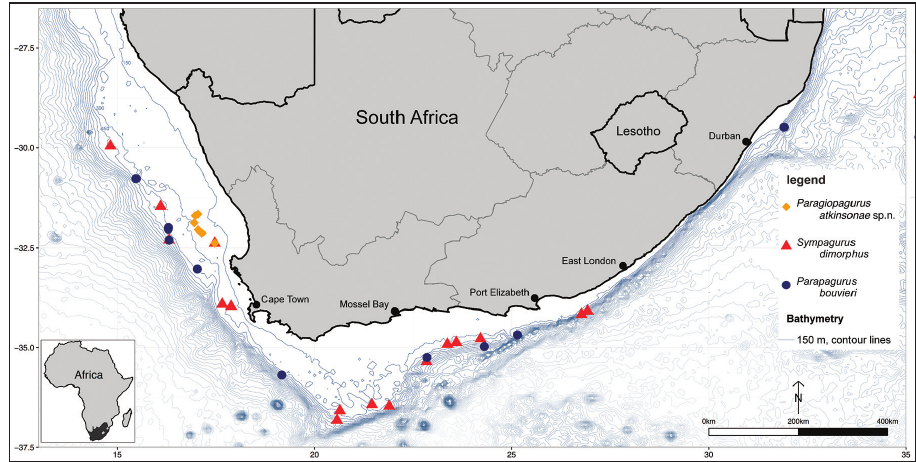
Figure 8. South African distribution of three parapagurid species based on specimens found during DAFF demersal research